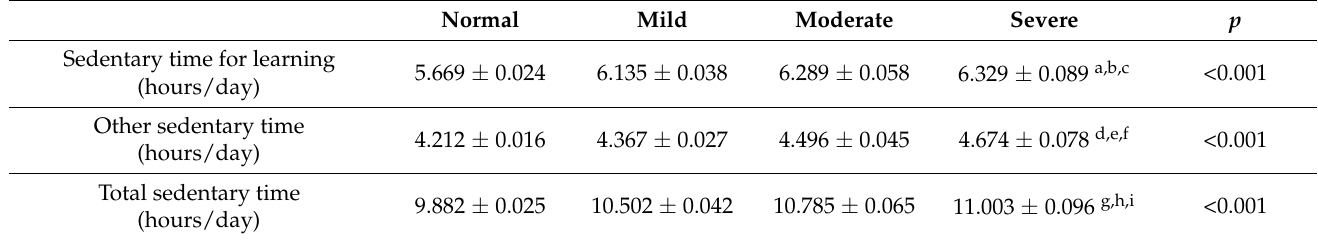
Table 3. Difference in each sedentary time according to level of GAD-7.